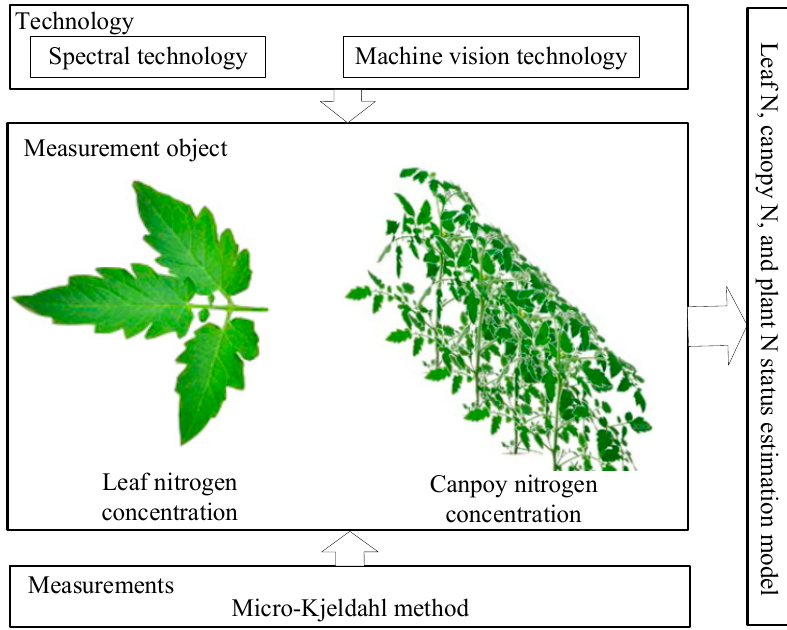
Figure 2. Basic principles of N non-destructive diagnosis.